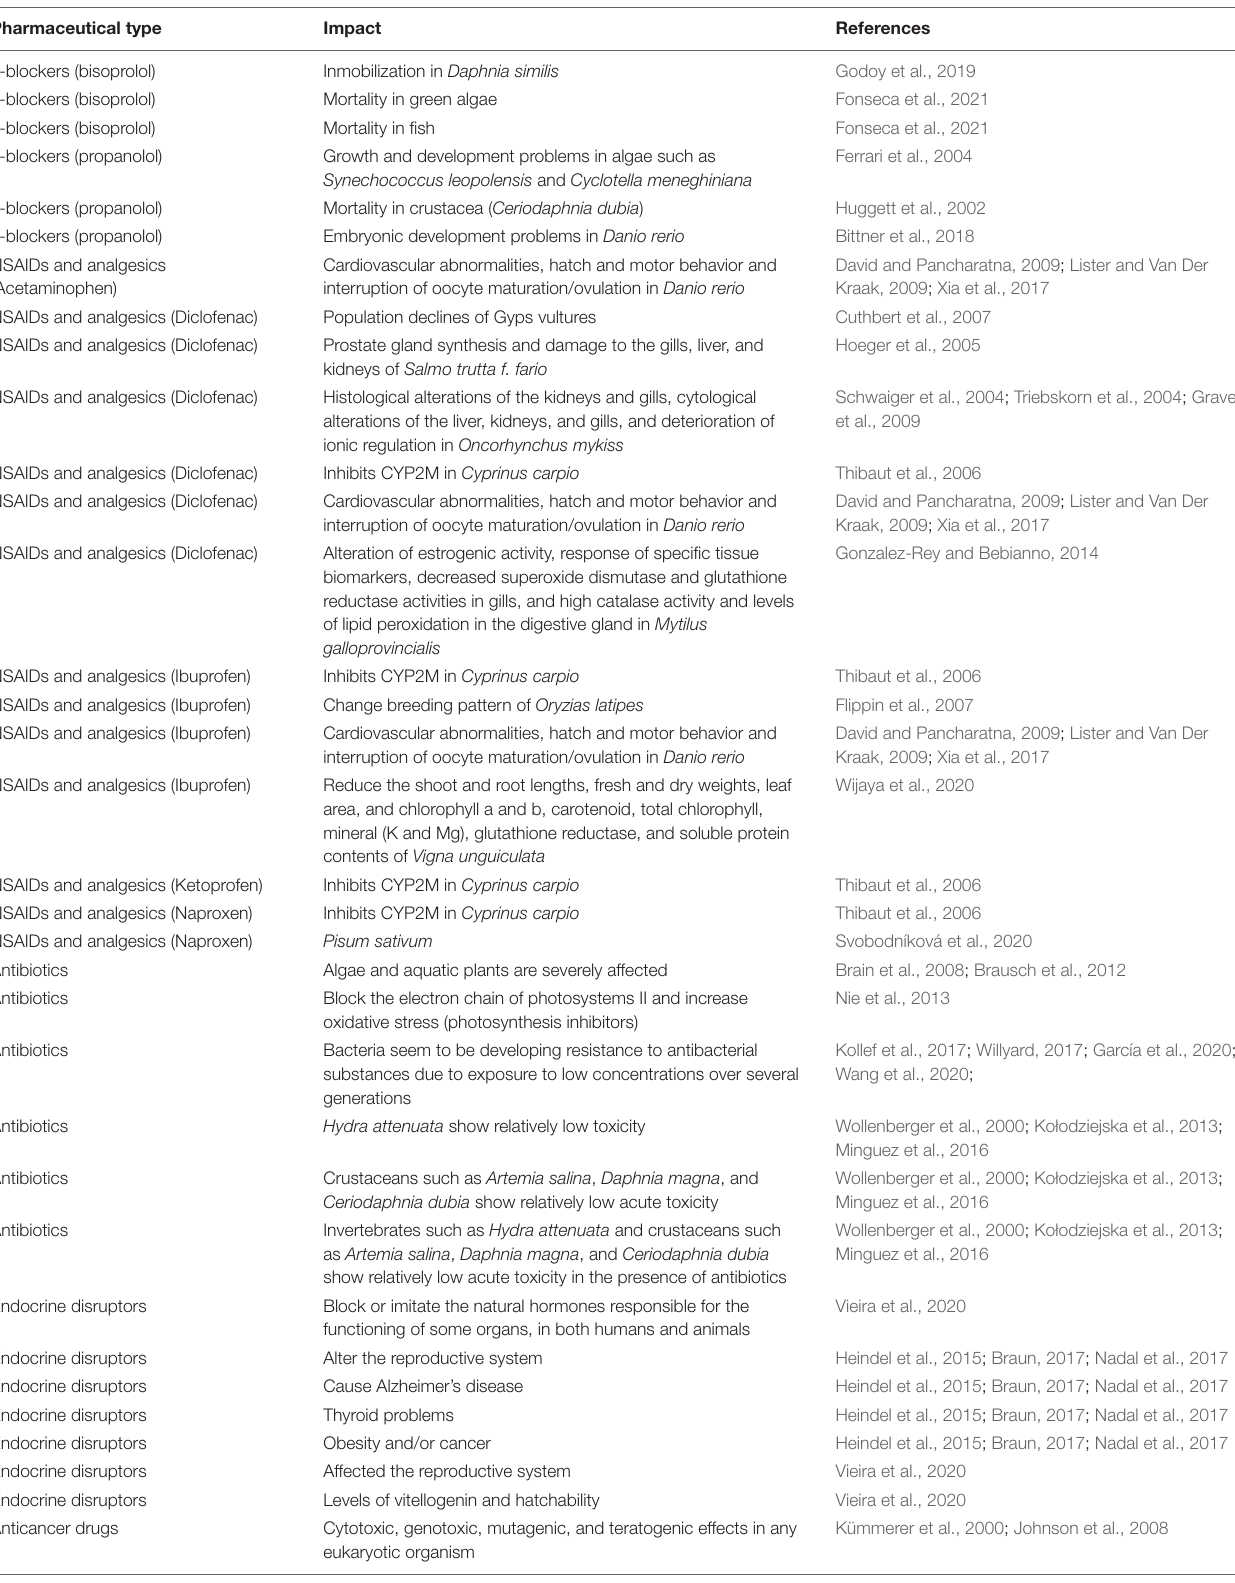
TABLE 2 | Impact of pharmaceuticals on the environment and